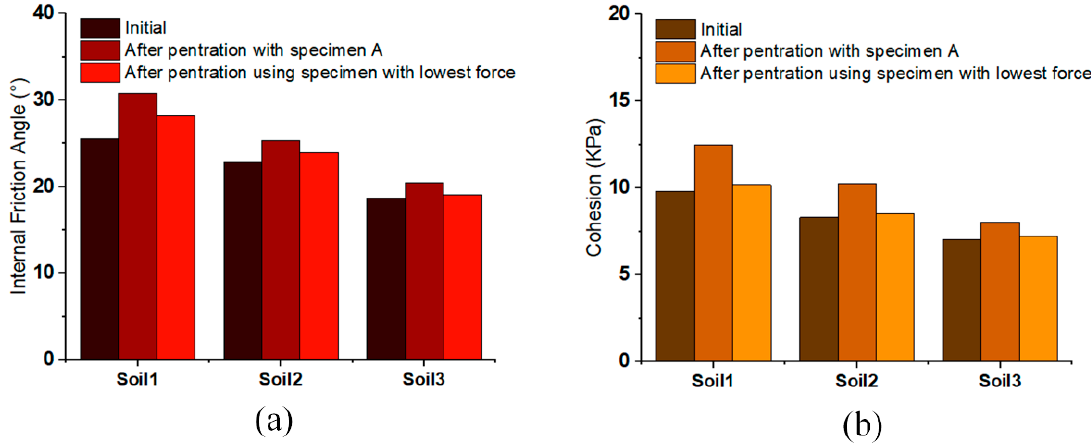
Figure 1. ( a ) The internal friction angle cohesion and ( b ) the cohesion of the soils before and after